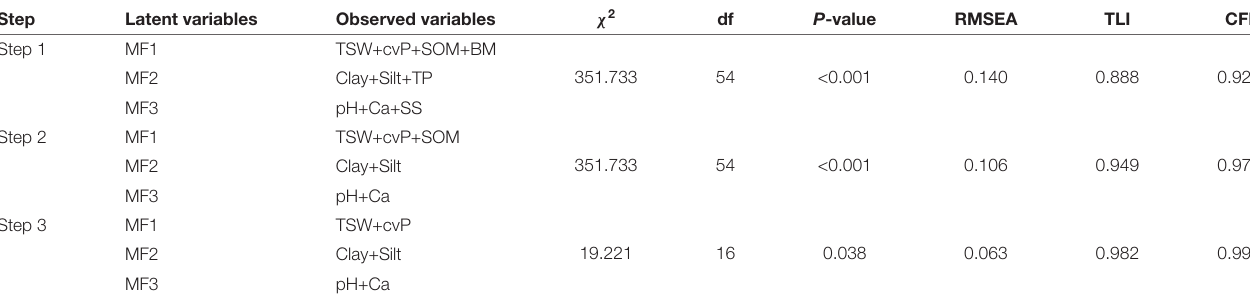
TABLE 3 | Results of the structural equation model (SEM) fitting and stepwise deletion of observed